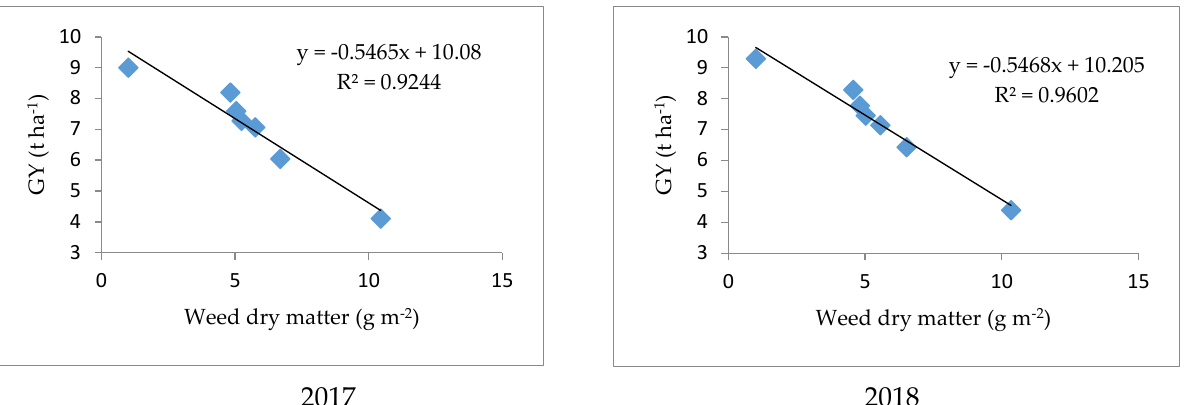
Figure 12. Linear regression line among crop establishment methods between K uptake by weeds vs. Grain yield (GY).